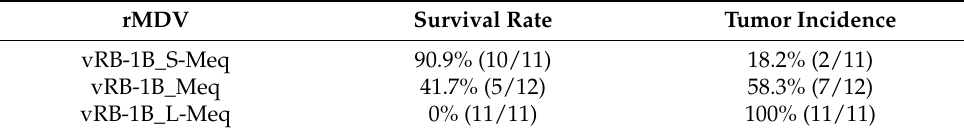
Table 3. Survival rate and tumor incidence at 56 days post-infection.